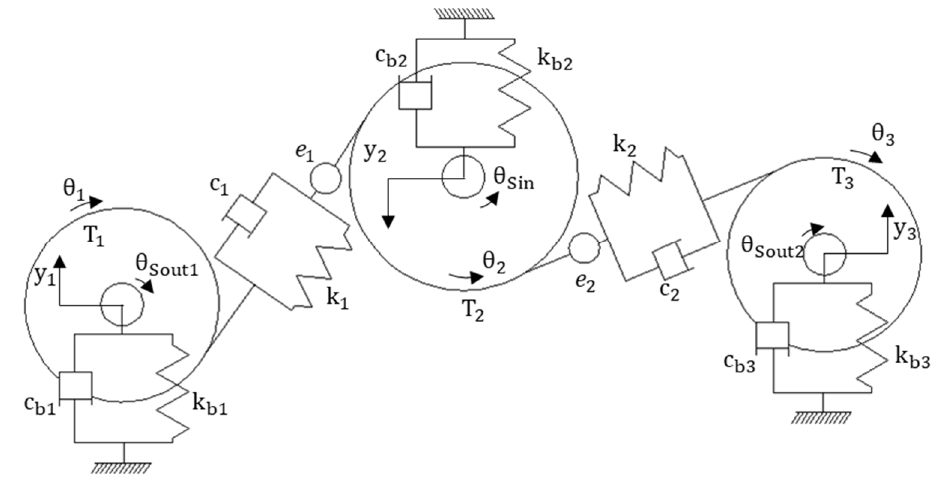
Figure 2. Schematic of the torque split model for 12 degrees of freedom.